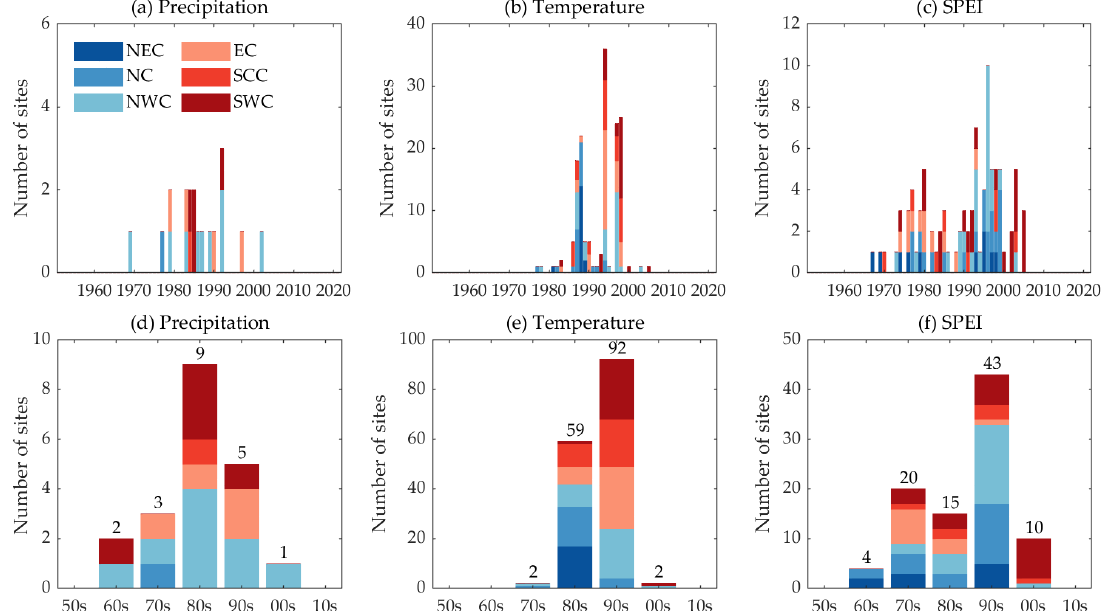
Figure 4. Number of stations with significant breaks among years during 1951–2021: ( a ) precipitation; ( b ) temperature; and ( c ) the SPEI. Number of stations with significant breaks among eras from 1950s to 2010s: ( d ) precipitation; ( e ) temperature; and ( f ) the SPEI. The numbers on the bars indicate the total number of sites with significant